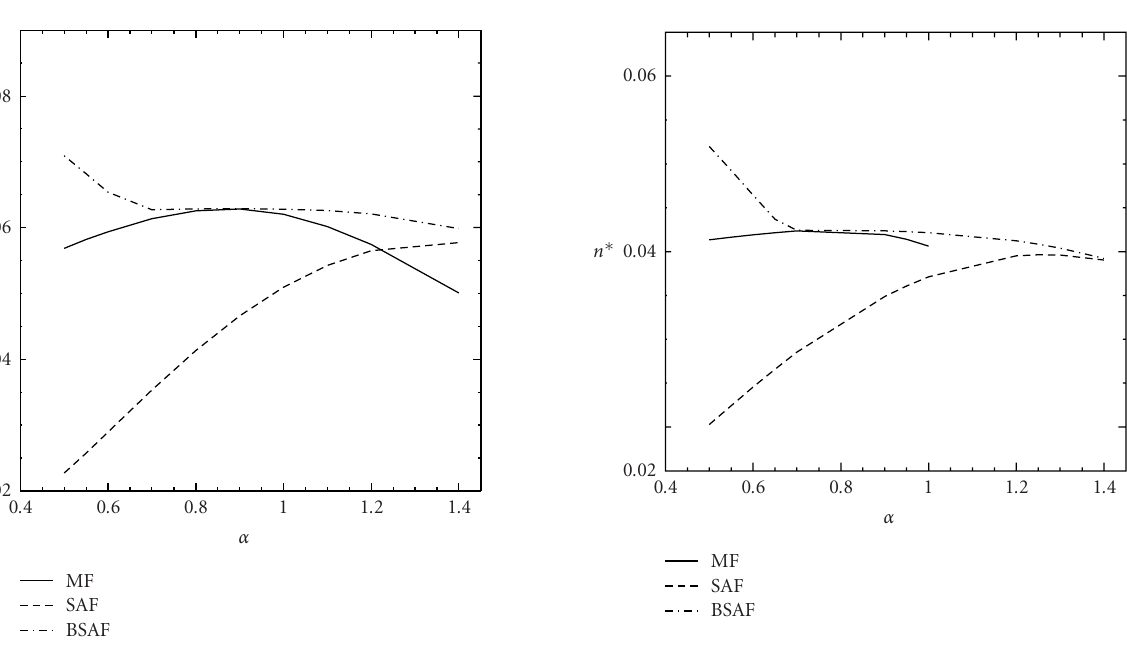
Figure 2: The expected number density of detections n ∗ as a func- tion of α for γ = 0 for the BSAF ( c has been obtained by maximizing the number of detections for each value of α ), MF, and SAF filters.